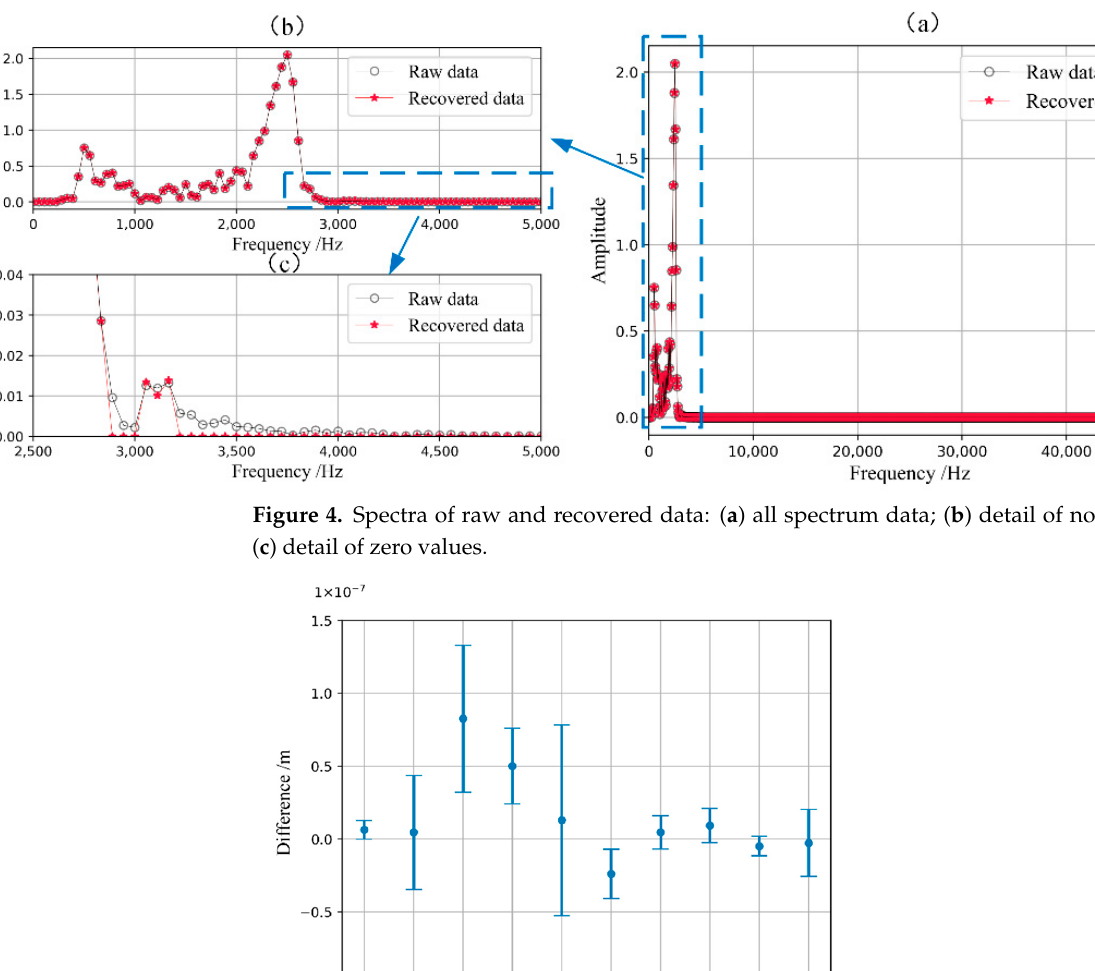
Figure 4. Spectra of raw and recovered data: ( a ) all spectrum data; ( b ) detail of non-zero values; ( c ) detail of zero values.